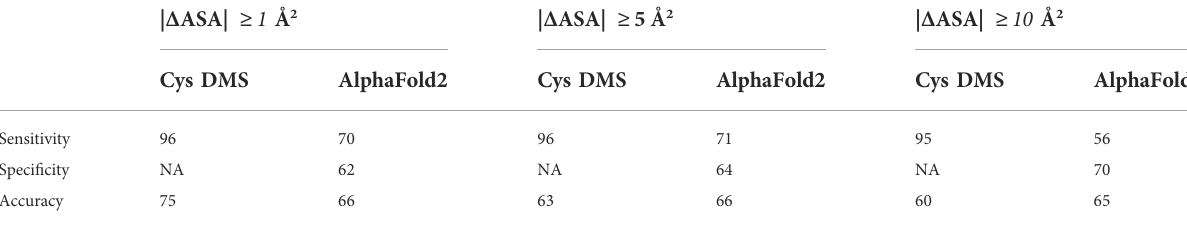
TABLE 1 Comparison of performance between Cysteine DMS and AlphaFold2 with MazEF9 crystal structure (PDB ID: